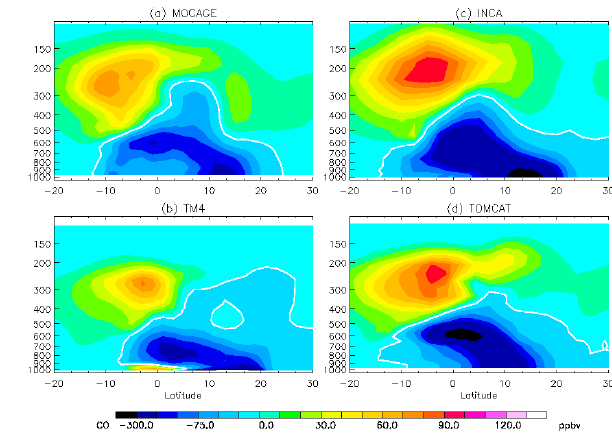
Fig. 6. August 2006 distributions of 250hPa CO difference between LiNO x -off and Conv-off simulations by (a) MOCAGE (b) TM4 (c) INCA and (d) p-TOMCAT.